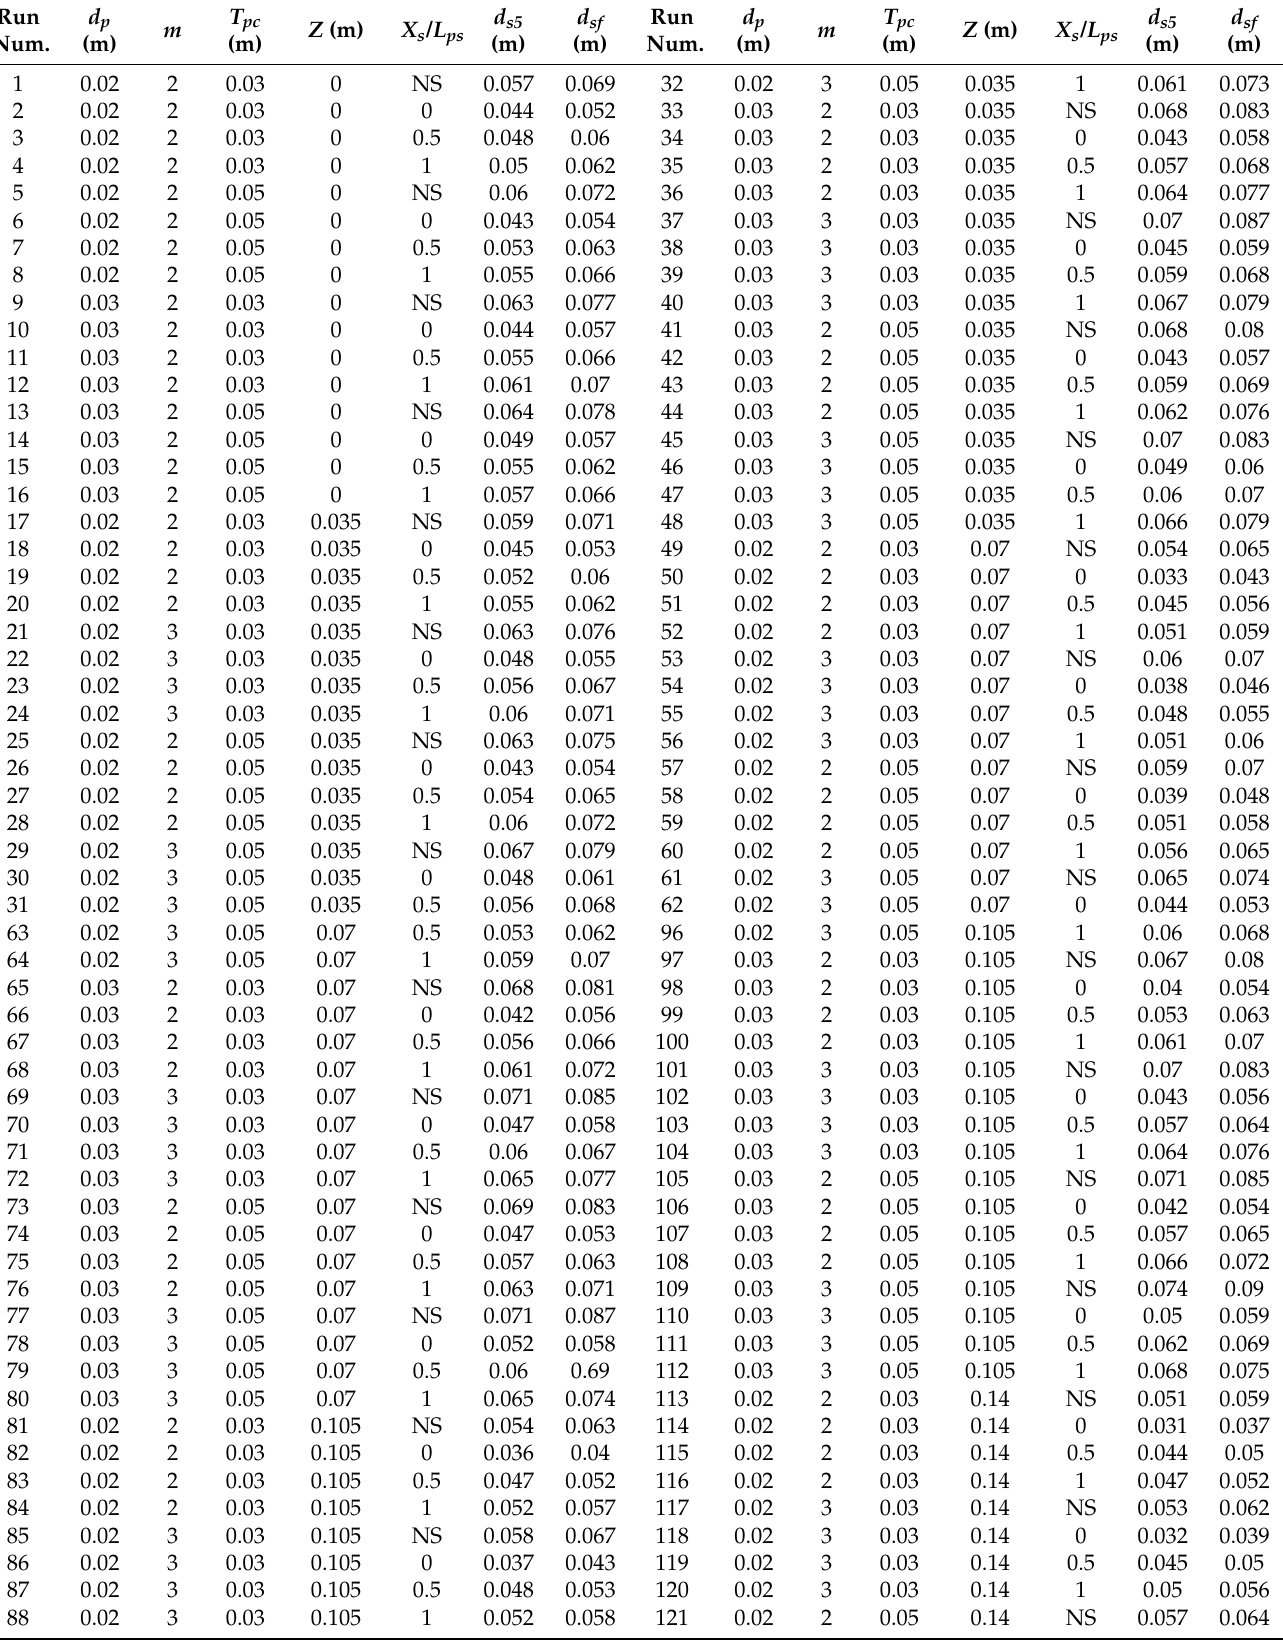
Table 1. Details of the experimental runs; note that d s5 is the maximum scour depth at tU / D = 1.5 × 10 5